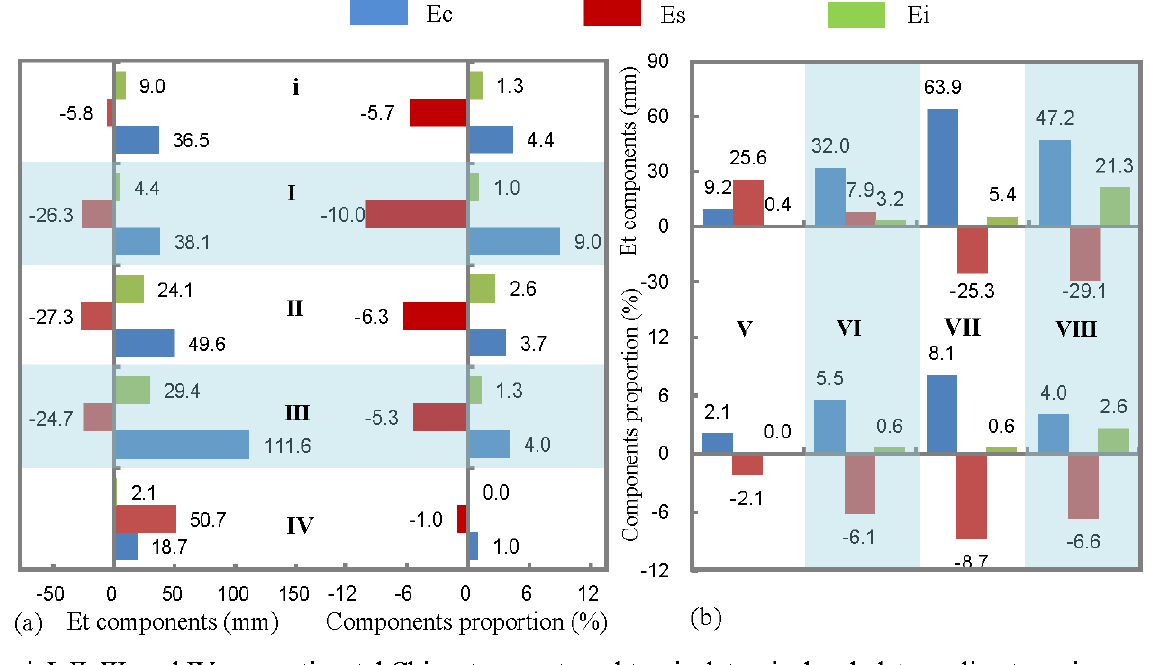
Figure 5. The changes of ET components for different climate zones and moisture regions during 2001 – 2020.